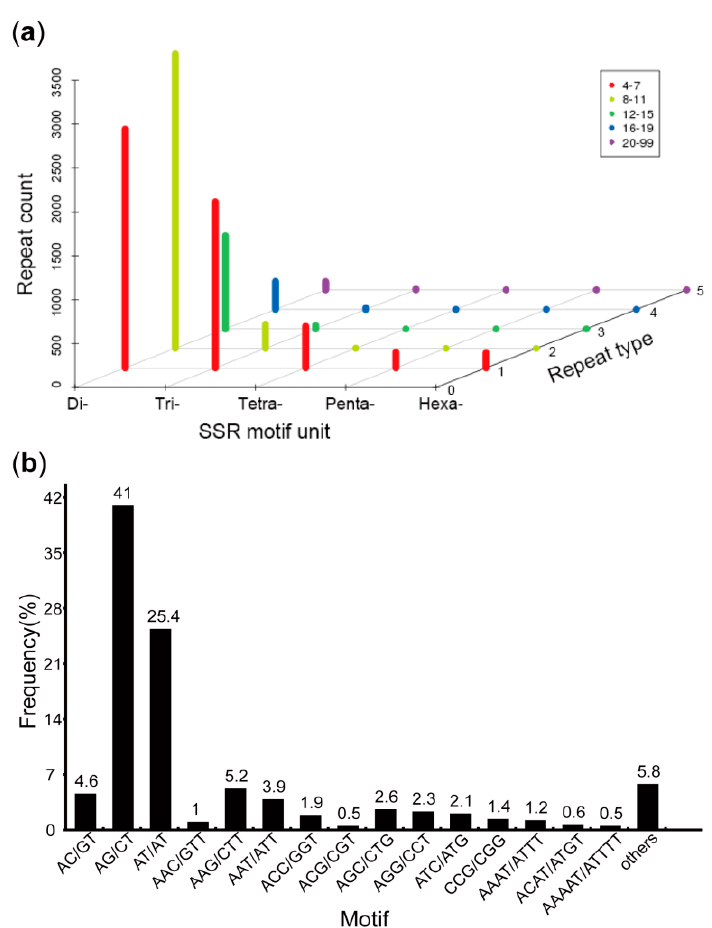
Figure 5. Distribution of simple sequence repeat (SSR) nucleotide classes among different nucleotide types in the transcriptome of M. pasquieri . ( a ) Distribution statistics for six types of SSRs from M. pasquieri . ( b ) The proportion of SSRs of different types of tandem repeat elements in total SSRs.